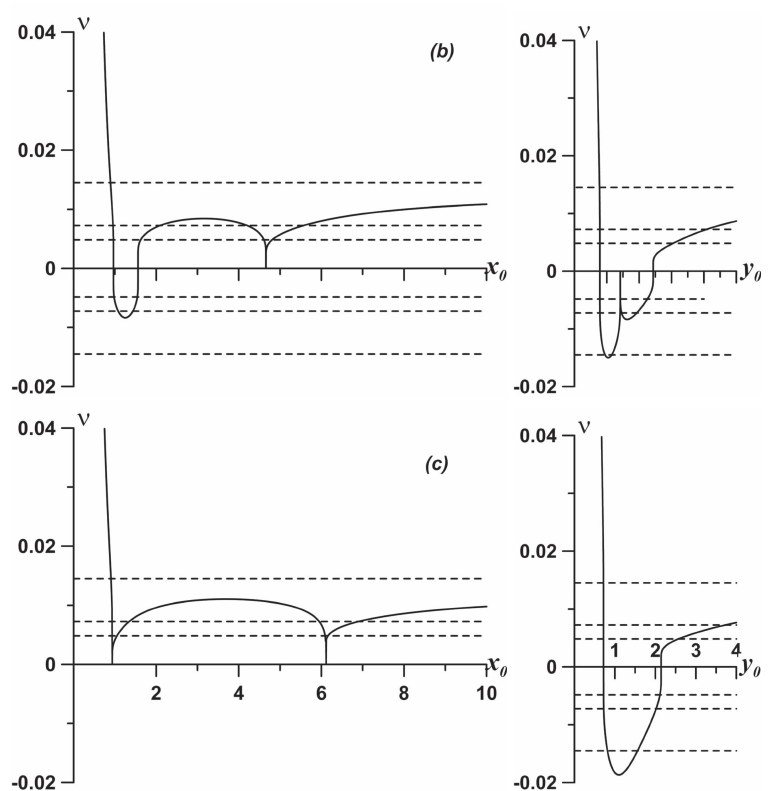
Figure 6. Steady-state rotation frequencies depending on the initial position at the corresponding symmetry axis for the phase portraits shown in Figure 5: ( a ) 1.2; ( b ) 2.1; and ( c ) 1.1. The dashed